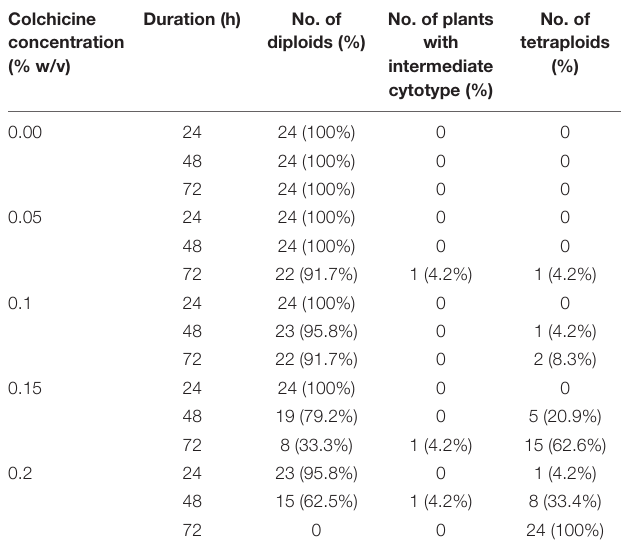
TABLE 2 | The ploidy level of in vitro plantlets regenerated from colchicine treated ECAs of Magnolia officinalis by somatic